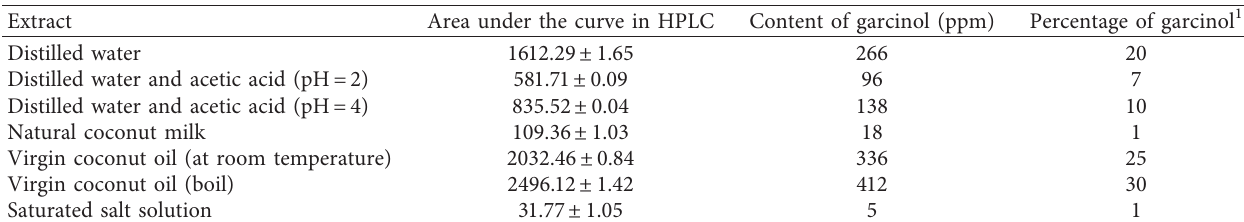
Table 2: Percentage of garcinol content in differently processed extracts of G. quaesita simulating cooking conditions. Extract Area under the curve in HPLC Content of garcinol (ppm) Percentage of garcinol 1